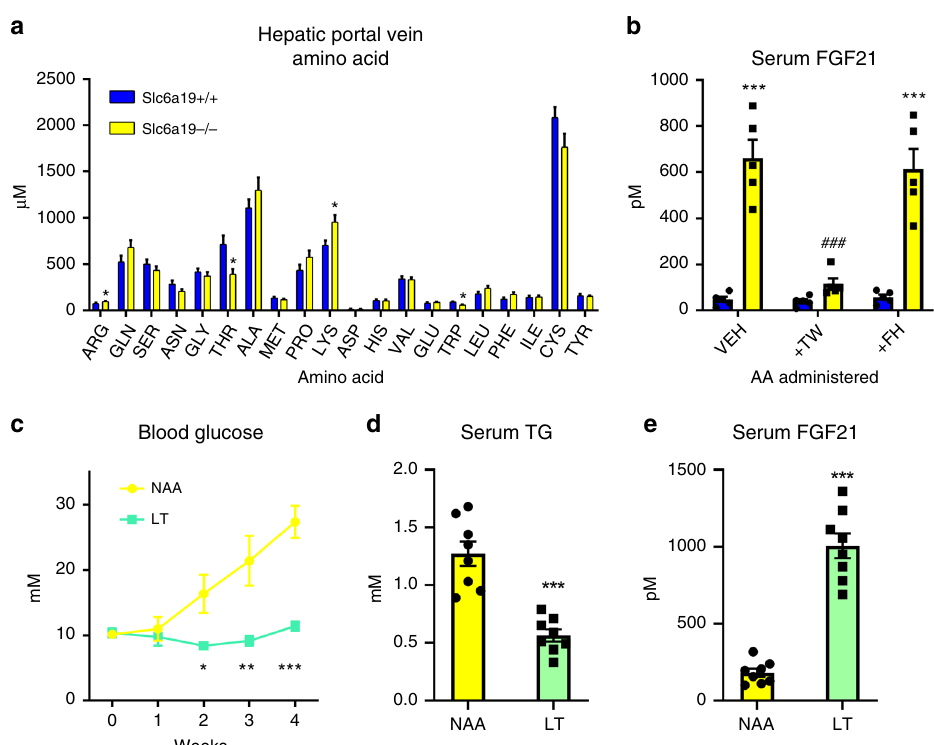
Fig. 5 Threonine restriction is a common feature of other models of systemic AA restriction and retards obesity-induced metabolic dysfunction in mice. a Hepatic portal vein serum amino acid (AA) concentrations in Slc6a19 knockout ( − / − ) or wildtype ( + / + ) littermate mice in the refed state on a standard control diet. Data are mean and SEM; n = 5 individual mice per group group. Data were analysed by a Student ’ s t -test. Different than + / + : * P